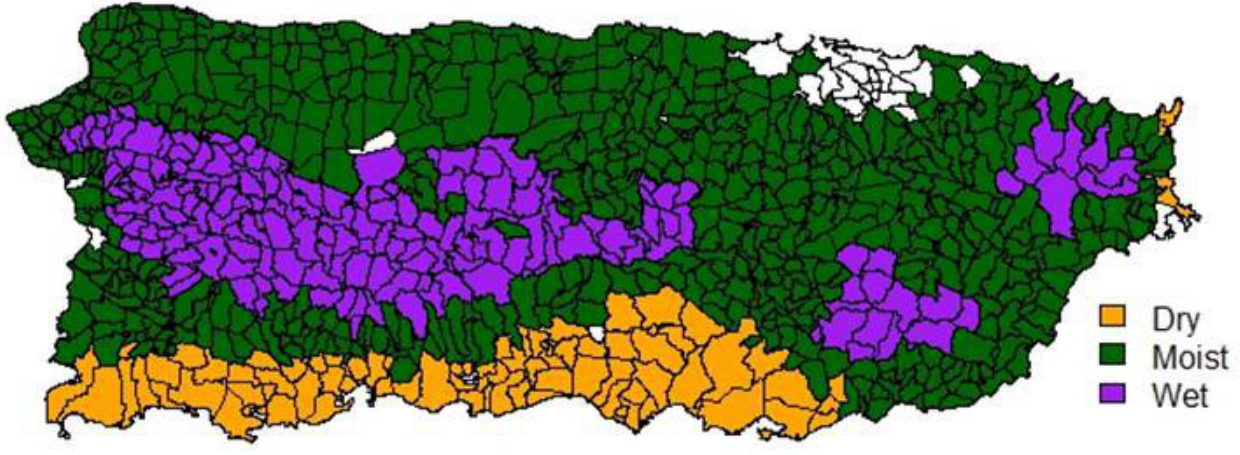
Fig. 4. Distribution of life zones in Puerto Rico (Daly et al.